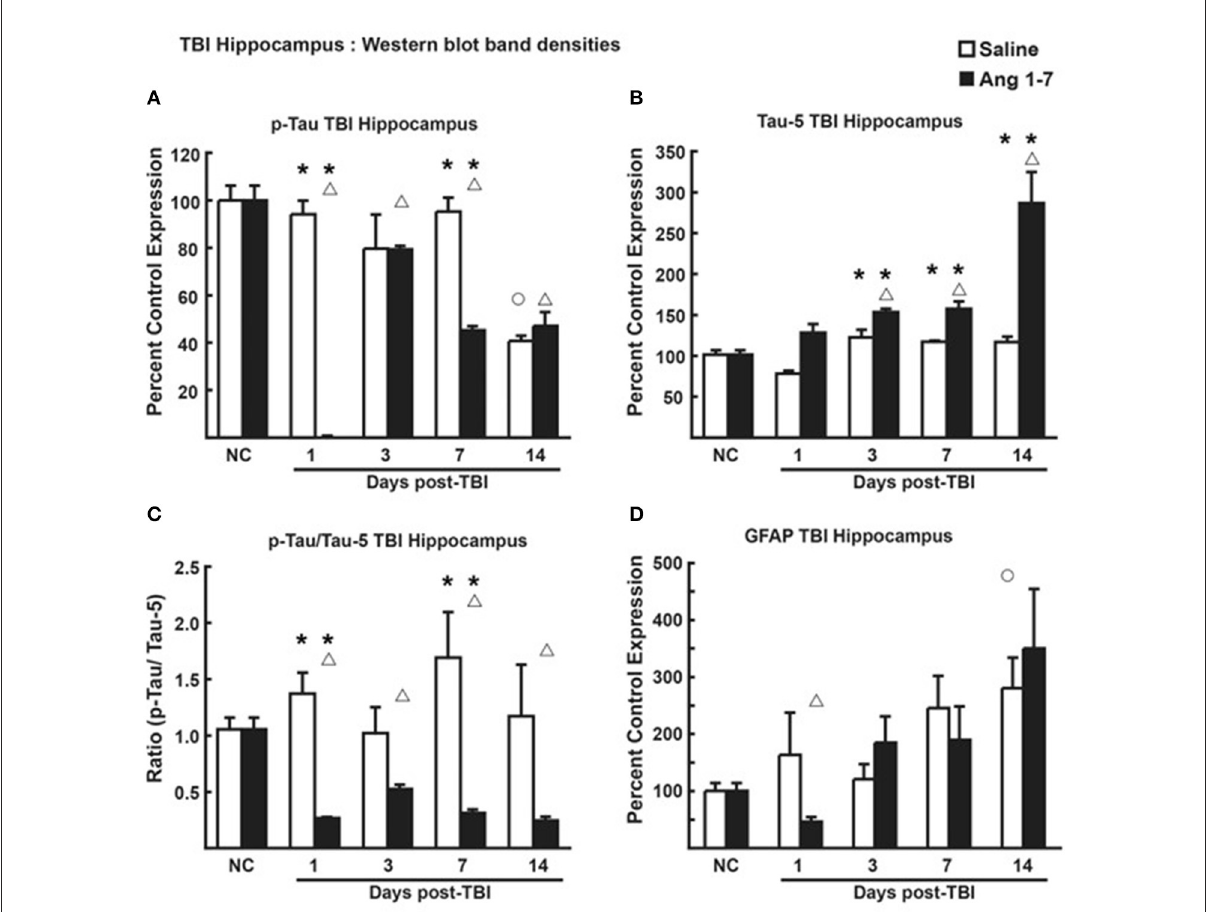
FIGURE7 Protein changes in hippocampus following TBI ( n = 3–4 mice/group). (A) Pooled protein densities of left hippocampus from Western blot studies demonstrate a significant decrease for pTau on days 1, 3, 7, and 14 after a mTBI in saline treated animals. Yet, a significant difference was seen on days 1 and 7 in Ang-(1-7) (1 mg/kg, i.p. days 1–5) treated animals as compared to saline with less pTau expression. There were no significant differences on days 3 and 14 between saline and Ang-(1-7) treatments. (B) There was a significant increase in Tau on days 3, 7, and 14 after the mTBI in the Ang-(1-7) treatment with day 14 doubling in the amount of hippocampal Tau protein due to Ang-(1-7) treatment. (C) The pTau:Tau ratio demonstrated a significant difference on days 1 and 7 with Ang-(1-7) demonstrating a significant decrease in pTau as compared to saline treated animals. A similar trend was seen on days 3 and 14. (D) GFAP was represented as Percent Control Expression for post-TBI days 1, 3, 7, and 14. GFAP expression in cortex demonstrated an increase in levels from baseline on days 3, 7, and 14 with no significant difference between treatment groups. NC (normal control) is pre-TBI control protein levels standardized to a value of 100. “ ◦ ” indicates a statistically significant difference ( p < 0.05) in expression level or ratio between the selected post-TBI day and baseline for saline treated animals. “ 1 ” indicates a statistically significant difference ( p < 0.05) in expression level or ratio between the selected post-TBI day and baseline for Ang-(1-7) treated animals. * indicates a statistically significant difference ( p < 0.05) in expression level or ratio between the Ang-(1-7) and Saline treated groups. * P <